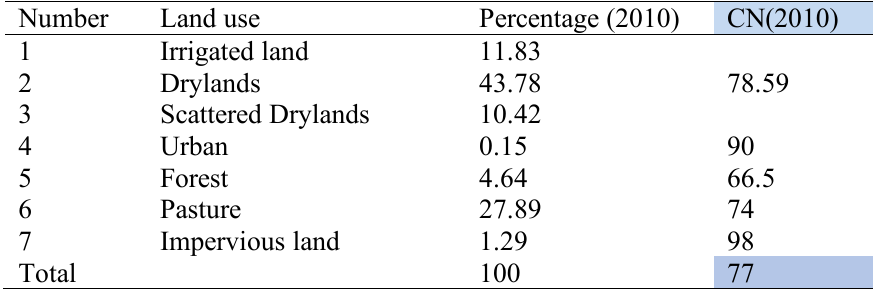
Table 2. Land use distribution in the Ilam watershed.